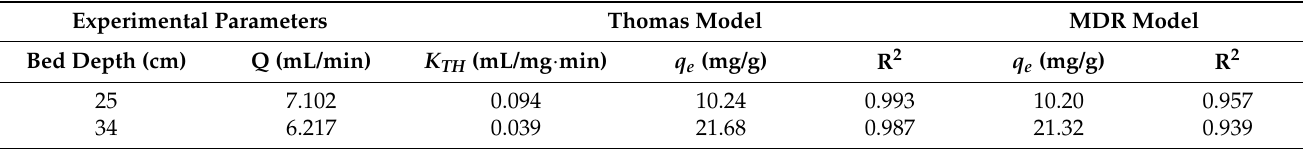
Table 2. Fitted Thomas and Modified Dose Response (MDR) model parameters for agitated tubular reactor (ATR) breakthrough tests. Sr 2+ concentration was set at a 100 ppm concentration and trials maintained a 15 min residence time along the active column length.